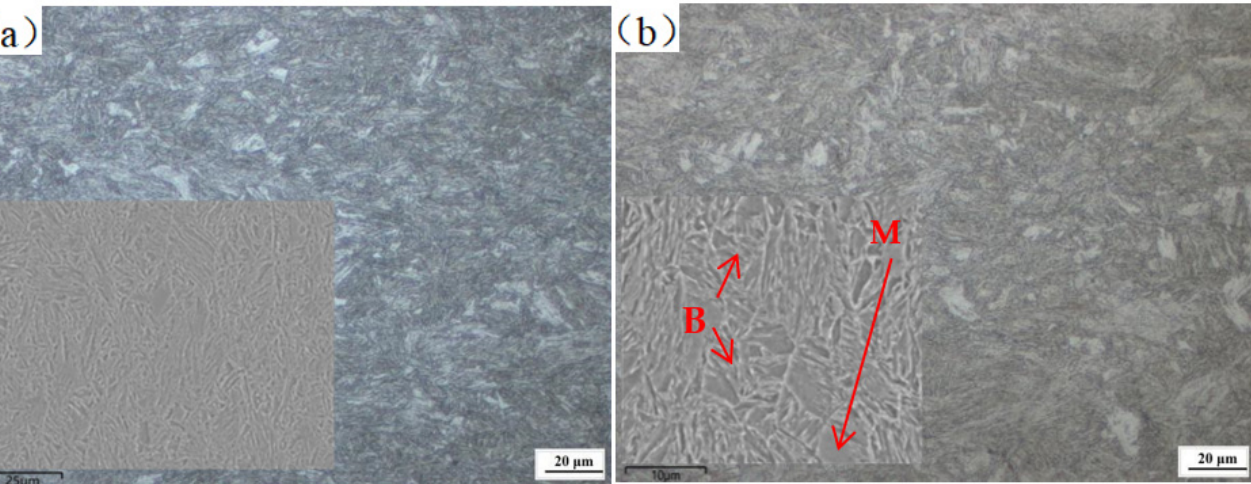
Figure 12. Microstructure of 1# as plate tested steel (( a , b ) represent 1/4, 1/2 thickness, respectively).